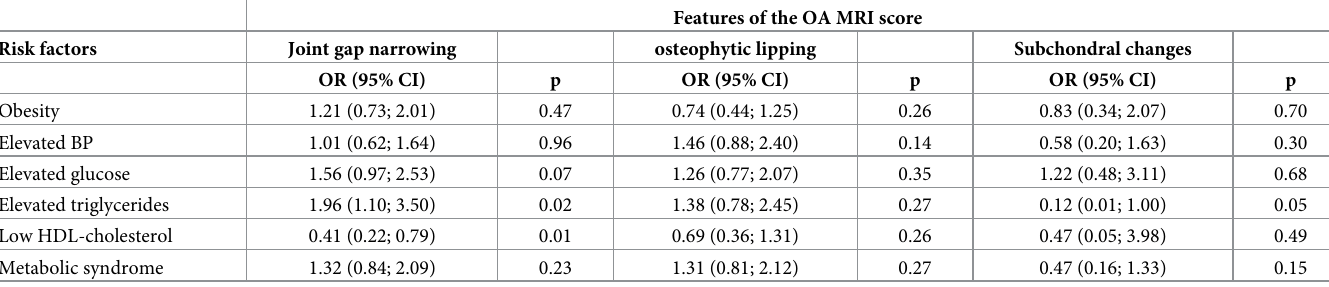
Table 4. Association of metabolic syndrome and its components with features of the OA MRI score for the right